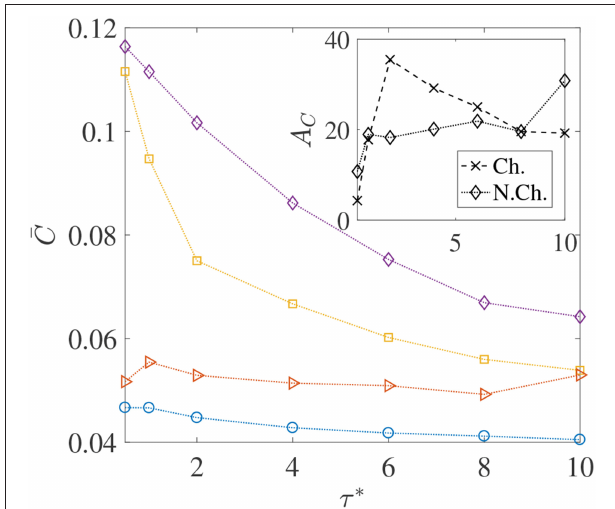
FIGURE 7 | The variation in the average nutrient exposure, ¯ C , for chemotactic and non-chemotactic bacteria, with strong and weak hydrodynamic interactions, as a function of the (dimensionless) mean run-time τ ∗ . The legends in the main figure are as follows: 3 − chemotactic, α D = 2; 2 − chemotactic, α D = 0.1; (cid:3) − non-chemotactic, α D = 2; (cid:13)− non-chemotactic, α D = 0.1. Inset: The hydrodynamic amplification, A C , as a function of τ ∗ . The other parameters are: R = 45, K 1ρ = 0.0109, Sc =